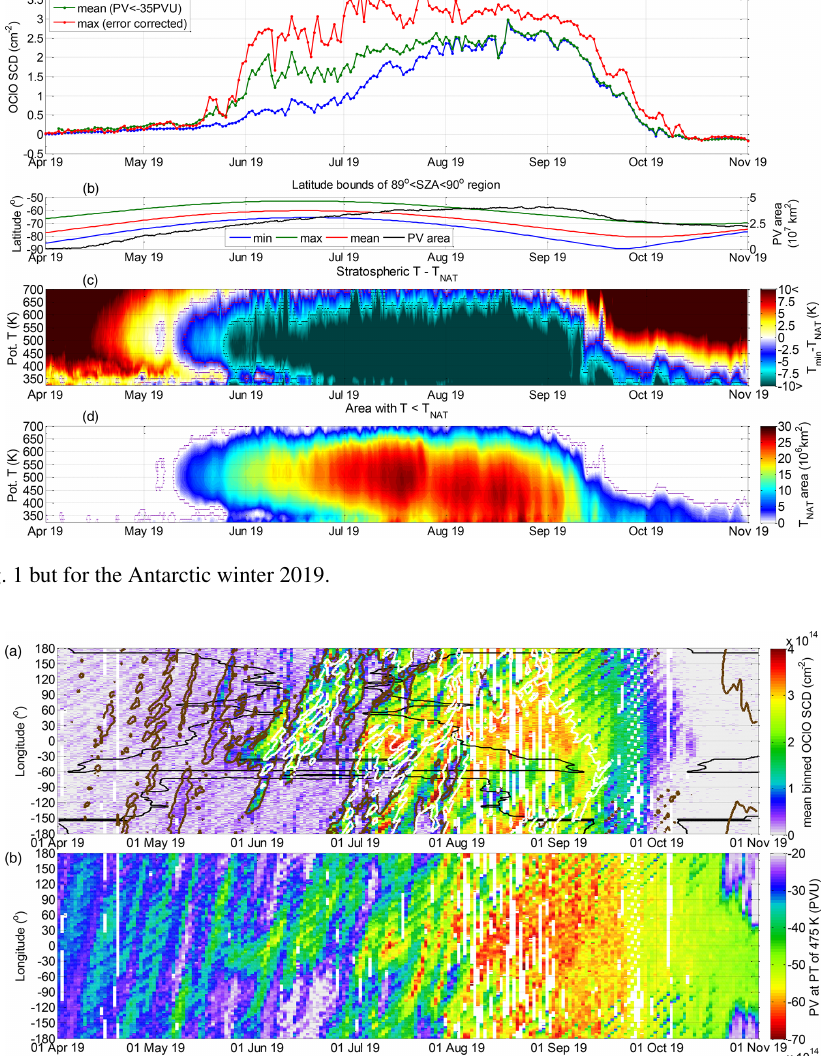
https://doi.org/10.5194/acp-22-245-2022 Atmos. Chem. Phys., 22, 245–272,